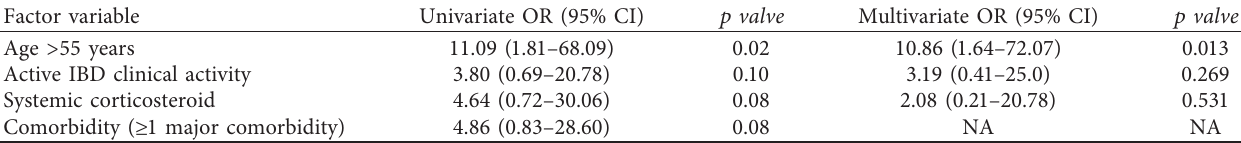
Table 4: Predictive factors associated with severe COVID-19